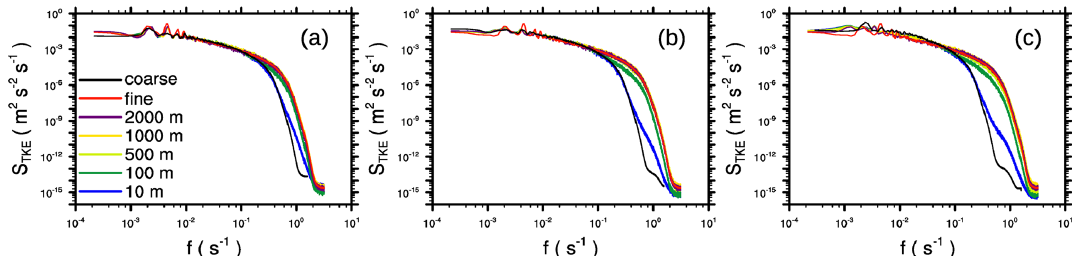
Figure 12. Frequency spectra of the resolved-scale TKE taken at different sampling locations downstream of the inflow boundary for the neutrally stratified boundary layer at z = 40m for grid-spacing ratio (a) 2, (b) 3, and (c) 4. TKE spectra for the fine-grid (and the corresponding coarse-grid) reference simulations are also shown.